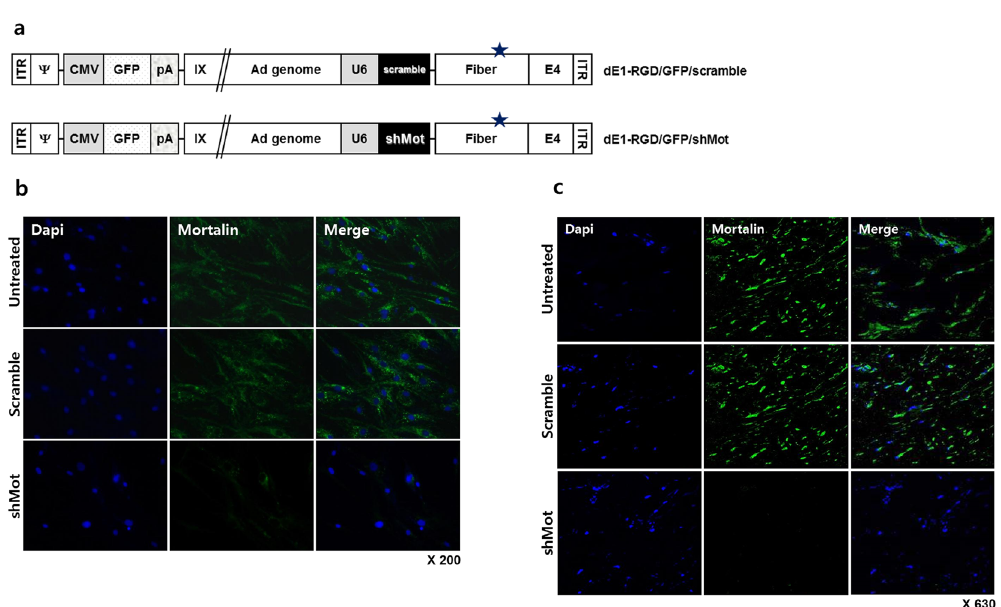
Figure 3. Construction of shMot-expressing adenovirus. ( a ) Schematic representation of the shMot-expressing adenoviral vectors. The RGD-incorporated adenovirus was generated by inserting RGD motif between HI- loop of the fiber knob (star). (ITR = inverted terminal repeat; Ψ = packaging signal; pA = polyA sequence; IX = protein IX; and shMot = mortalin-specific small hairpin (sh)RNAs). ( b ) Mortalin expression in keloid fibroblasts (KFs) after transduction with dE1-RGD/GFP/shMot. Scrambled shRNA not targeting any known human gene was used as a control. Overexpressed mortalin on the cytosolic and extracellular area of KFs, which were examined by immunofluorescence assay, were extremely knockdown by the treatment of dE1-RGD/GFP/ shMot. Double immunostaining images of KFs show mortalin knockdown (mortalin, green; nucleus, blue; × 200). ( c ) The similar results were obtained on the primary keloid spheroids after infection of dE1-RGD/GFP/ shMot